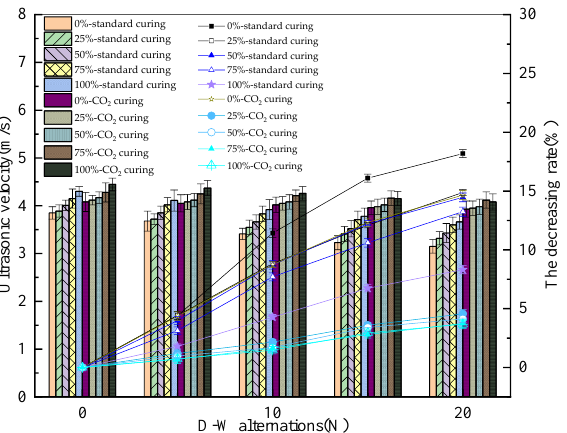
Figure 5. The ultrasonic velocity of reinforced alkali-activated mineral admixtures during D–W alternations.